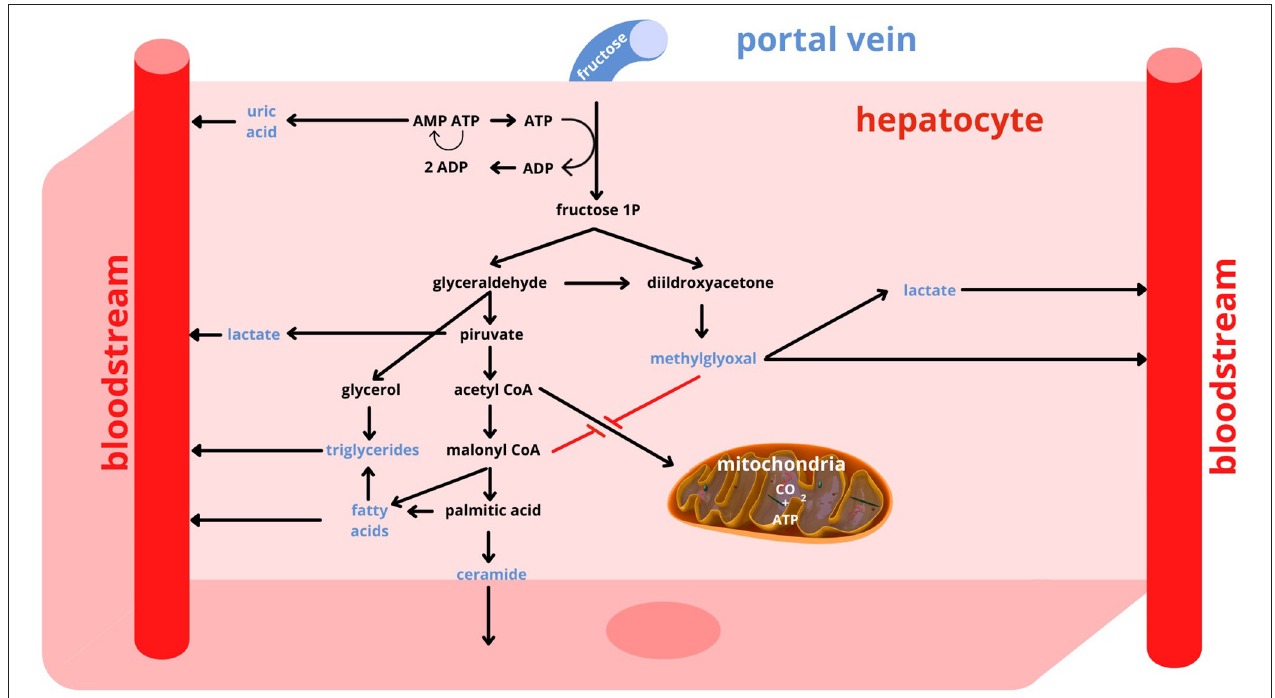
FIGURE 1 | Fructose metabolism. AMP, adenosine monophosphate; ADP, adenosine diphosphate; ATP, adenosine trisphosphate; CO 2 , Carbon